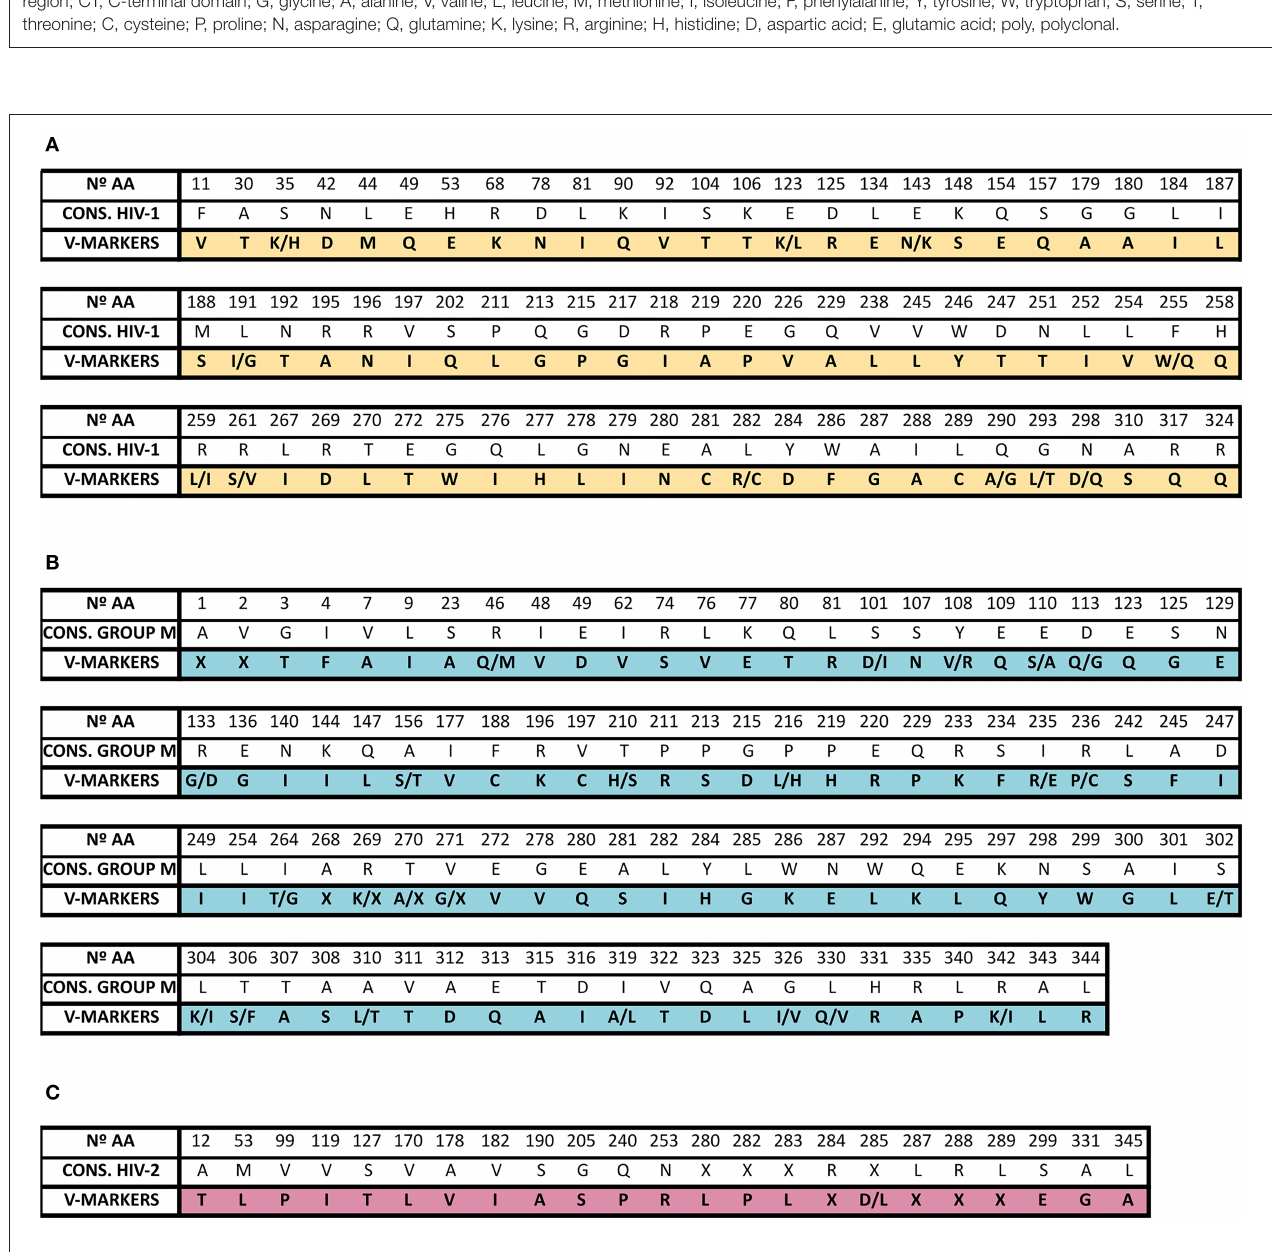
FIGURE 4 | Location of exclusive transmembrane glycoprotein V-markers in non-M groups (A) , HIV-1 group M variants (B) , and HIV-2 variants (C) . V-markers in gp41 HIV-1 non-M groups are described with respect to the HIV-1 consensus sequence (yellow color). V-markers in gp41 HIV-1 group M variants are described with respect to the HIV-1 group M consensus sequence (light-blue color). V-markers in gp36 HIV-2 variants are described with respect to the HIV-2 consensus sequence (light-pink color). These V-markers and their corresponding variant can be also found in Supplementary Table 3 (for HIV-1) and Supplementary Table 4 (for HIV-2). V-markers, aa changes that were specific for each variant present in ≥ 90% of gp41 or gp36 sequences of an exclusive HIV-1 or HIV-2 variant; N ◦ , number; AA, amino acids; CONS, aa consensus sequence; G, glycine; A, alanine; V, valine; L, leucine; M, methionine; I, isoleucine; F, phenylalanine; Y, tyrosine; W, tryptophan; S, serine; T, threonine; C, cysteine; P, proline; N, asparagine; Q, glutamine; K, lysine; R, arginine; H, histidine; D, aspartic acid; E, glutamic acid; X, aa deletion.